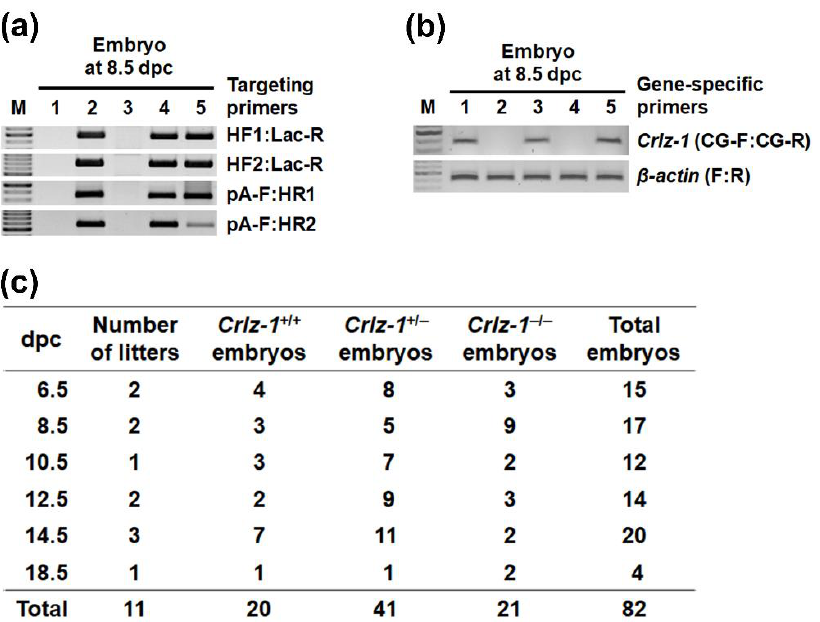
Figure 3. The embryos of various dpc from the mating pairs of Crlz-1 +/ − heterozygous KO mice by themselves were chased for their Crlz-1 − / − homozygous KO genotypes by the same strategy as drawn in panel a of Figure 2. ( a ) PCR using the genomic DNA obtained from the embryos at various dpc was performed with the primer pair indicated on the right of each gel. The representative genotyping PCR results from an embryo litter of 8.5 dpc are shown, where #1 and #3 embryos are wild-type whereas #2 and #4–5 embryos are targeted. ( b ) PCR using the same genomic DNA was subsequently performed with the primer pairs specific for Crlz-1 and β -actin genes to determine which embryos were homozygously targeted. The representative genotyping PCR results for the same litter in panel a are shown, where among the three targeted embryos, #2 and #4 embryos are found to be homozygous whereas #5 is heterozygous. ( c ) The embryos of each genotype at the various dpc are summarized in a table. M: DNA size